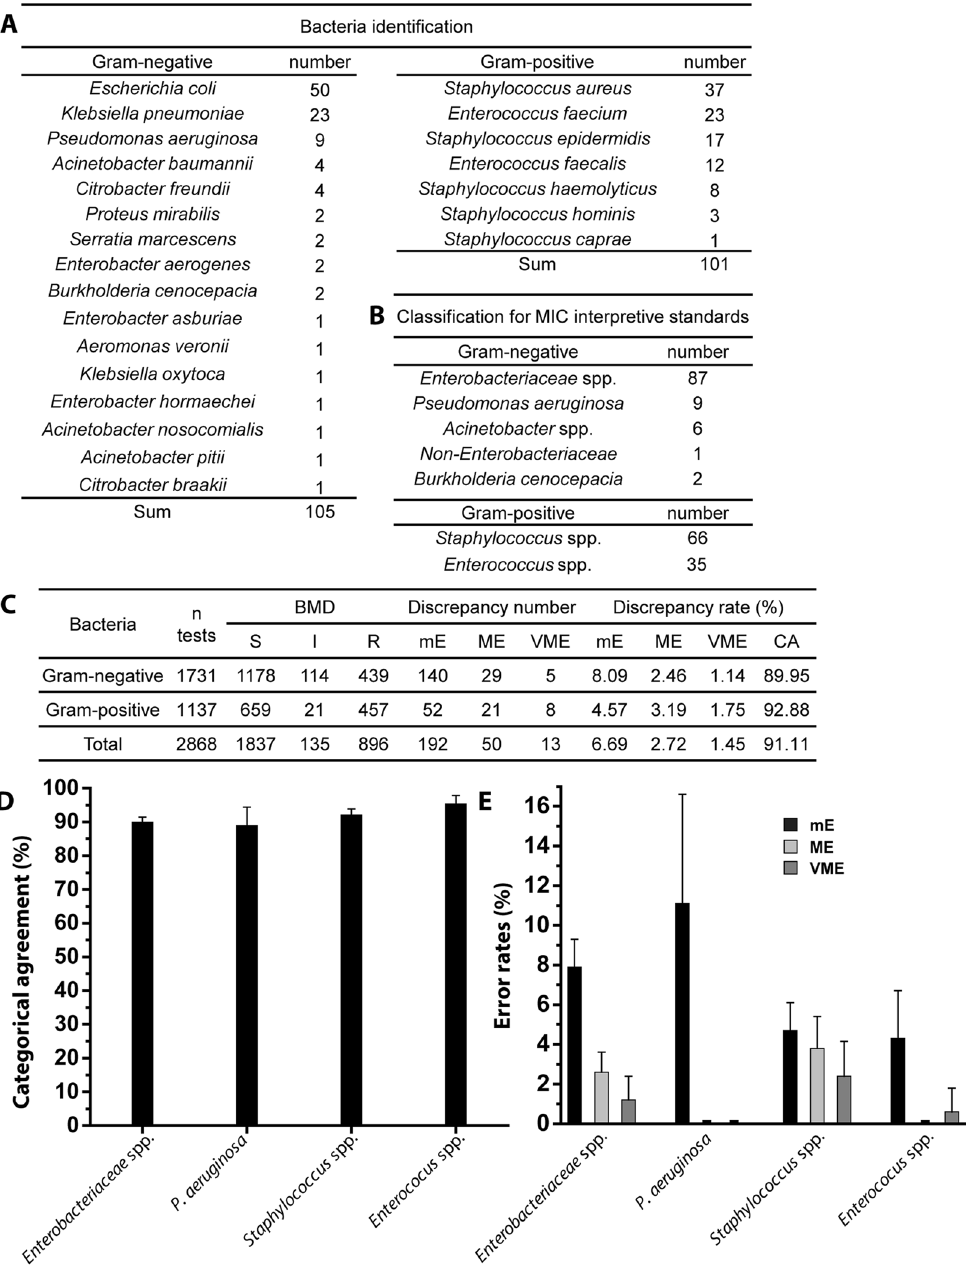
Figure 4. Summary of clinical testing with dRAST using colony-forming area detection. (A) Bacterial ID of 206 clinically isolated strains. There were 16 species of 105 Gram-negative strains and 7 species of 101 Gram- positive strains. (B) Classification of clinical samples for MIC interpretive standards. (C) Discrepancy rates and CA rates for dRAST using clinical samples. The dRAST results were compared with the BMD results to calculate the discrepancy rates. For the BMD test: S, susceptible; I, intermediate; R, resistant. For dRAST: mE, minor error; ME, major error; VME, very major error; CA, categorical agreement. (D) CA rates according to the main classified strains: Enterobacteriaceae spp. (n = 87, 89.9%), P. aeruginosa (n = 9, 88.9%), Staphylococcus spp. (n = 66, 92.1%), Enterococcus spp. (n = 35, 95.4%). (E) Discrepancy rates according to the main classified strains: Enterobacteriaceae spp. (mE = 7.9%, ME = 2.6%, VME = 1.2%), P. aeruginosa (mE = 11.1%, ME = 0.0%, VME = 0.0%), Staphylococcus spp. (mE = 4.7%, ME = 3.8%, VME = 2.4%), and Enterococcus spp. (mE = 4.3%, ME = 0.0%, VME = 0.6%). The error rates were calculated by comparing the AST results from each method with the BMD test. Error bars represent 95% confidence